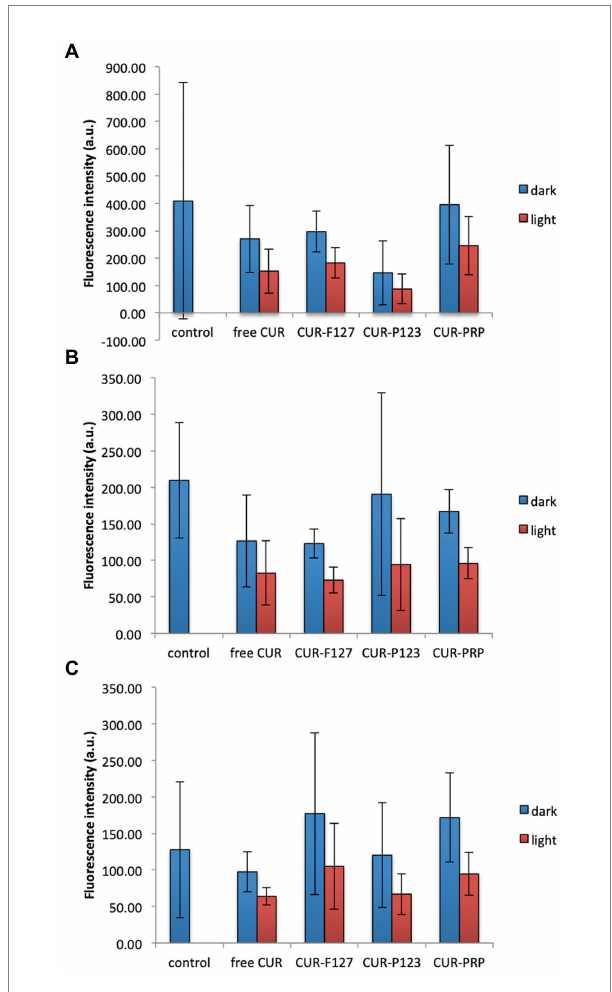
FIGURE 7 Mean values of intracellular ROS production (fluorescence intensity in arbitrary units, a.u.) of MRSA (A) , P. aeruginosa (B) , and C. albicans (C) after light irradiation of CUR in its free form and loaded into the micelles (F127, P123, and PRP) or incubation with the photosensitizers in the dark. Control: untreated cells. Error bars: standard deviation ( n = 3). The data was analyzed by ANOVA/Welch and Games-Howell post-hoc